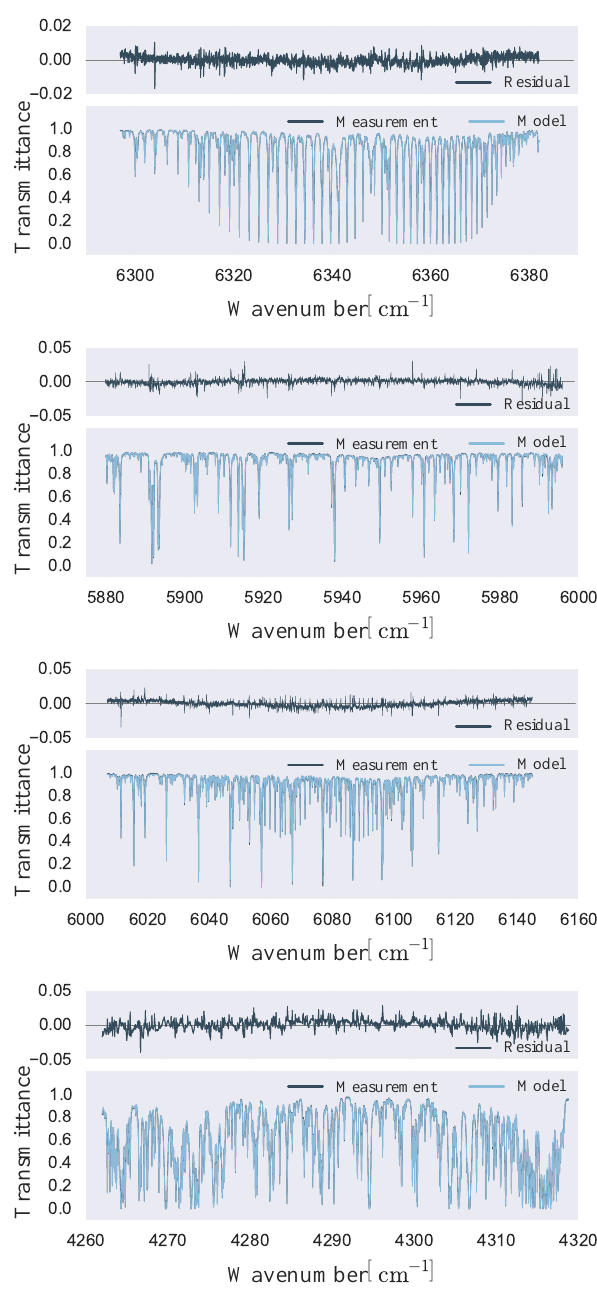
Figure A1. Spectral fits for a particular Karlsruhe spectrum: first panel, CO 2 (cw: 6339.5); second panel, CH 4 (cw: 5938.0); third panel, CH 4 (cw: 6076.0); fourth panel, CO (cw: 4290.4). All of the spectral fits show curvature in the residuals.